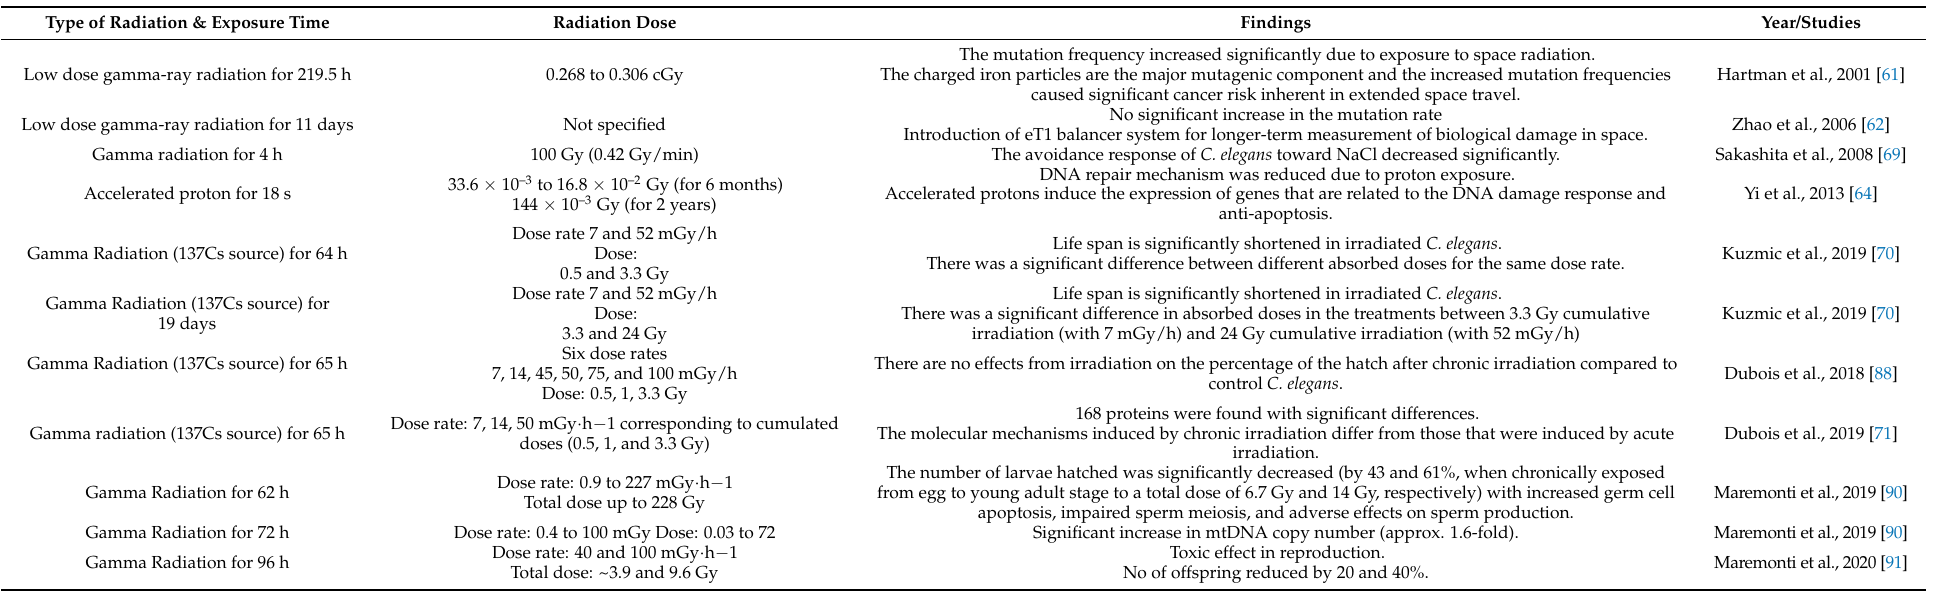
Table 2. Summary of Chronic Irradiation of C. elegans